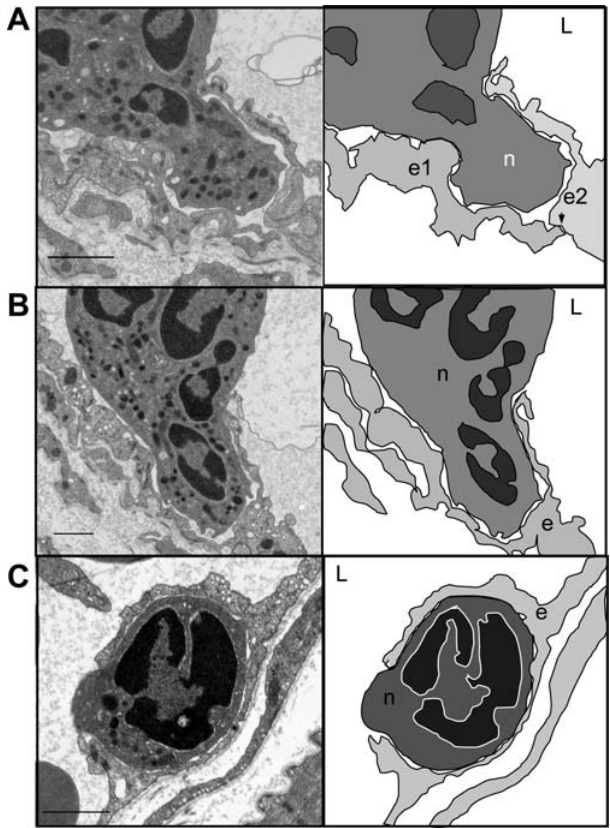
Figure 2. Endothelial transmigratory cup formation. Electron micrographs and cartoons of transmigrating wild-type neutrophils where the endothelium forms a transmigratory cup (A, B and C). The arrowheads mark the junctions and L marks the lumen of the blood vessel. e1, e2 and n represent individual endothelial cells and neutrophils respectively. The bar corresponds to 1 m m.